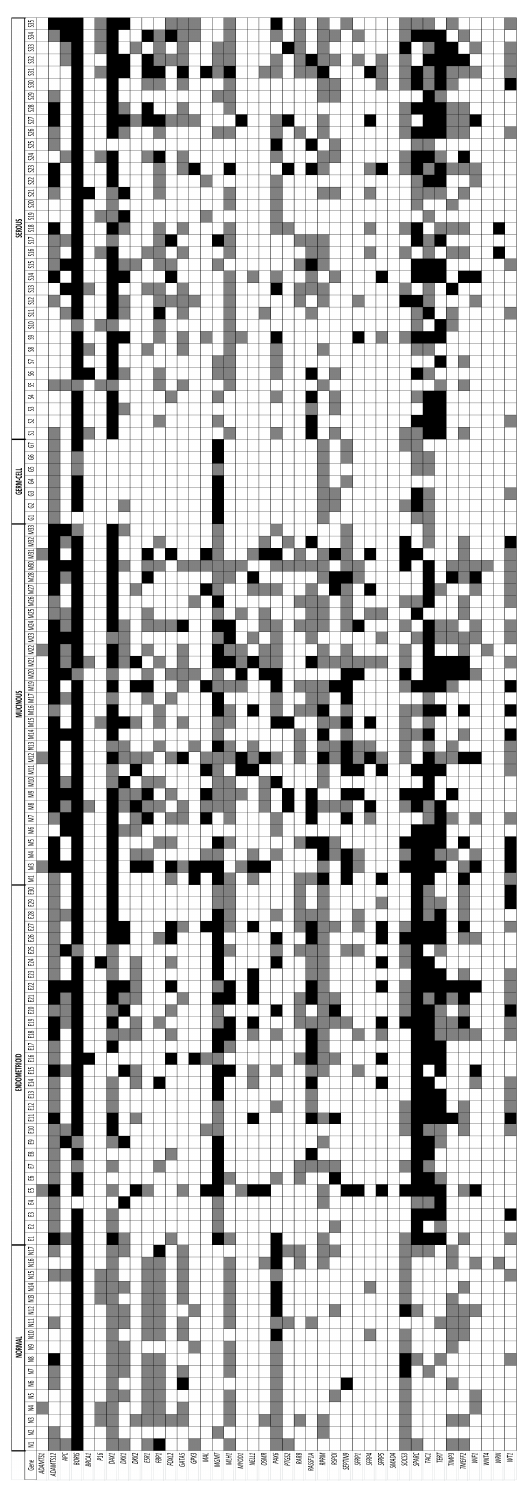
Figure 1. Methylation profiling by MLM in ovarian tumors. Methylation profiling of 41 gene promoters was performed in 17 normal ovarian tissues, and in 102 microdissected ovarian tumor tissues. Each row represents a gene and each column a tissue sample. Black boxes indicate high methylation ( β -value > 0.7), grey boxes intermediate or partial methylation ( β -value ≥ 0.3 and ≤ 0.7) and white boxes low methylation ( β -value < 0.3).